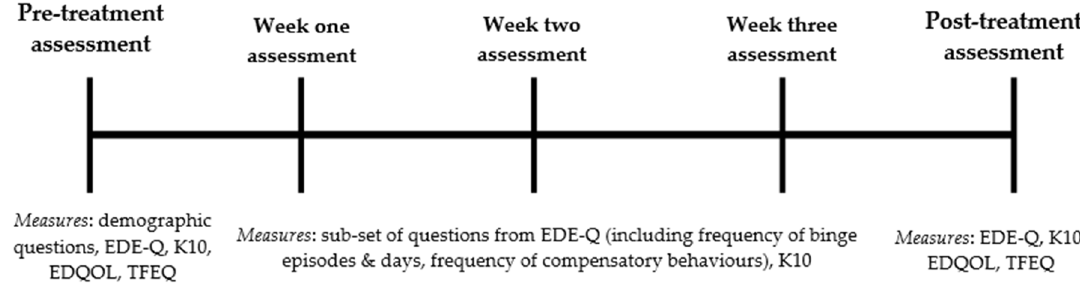
Figure 2. Schematic of the timing and sequence of assessments and included measures. Note: Week one, week two and week three assessments were identical. EDE-Q = Eating Disorder Examination-Questionnaire; K10 = Kessler Psychological Distress Scale; EDQOL = Eating Disorder Quality of Life Scale; TFEQ = Three Factor Eating Questionnaire.